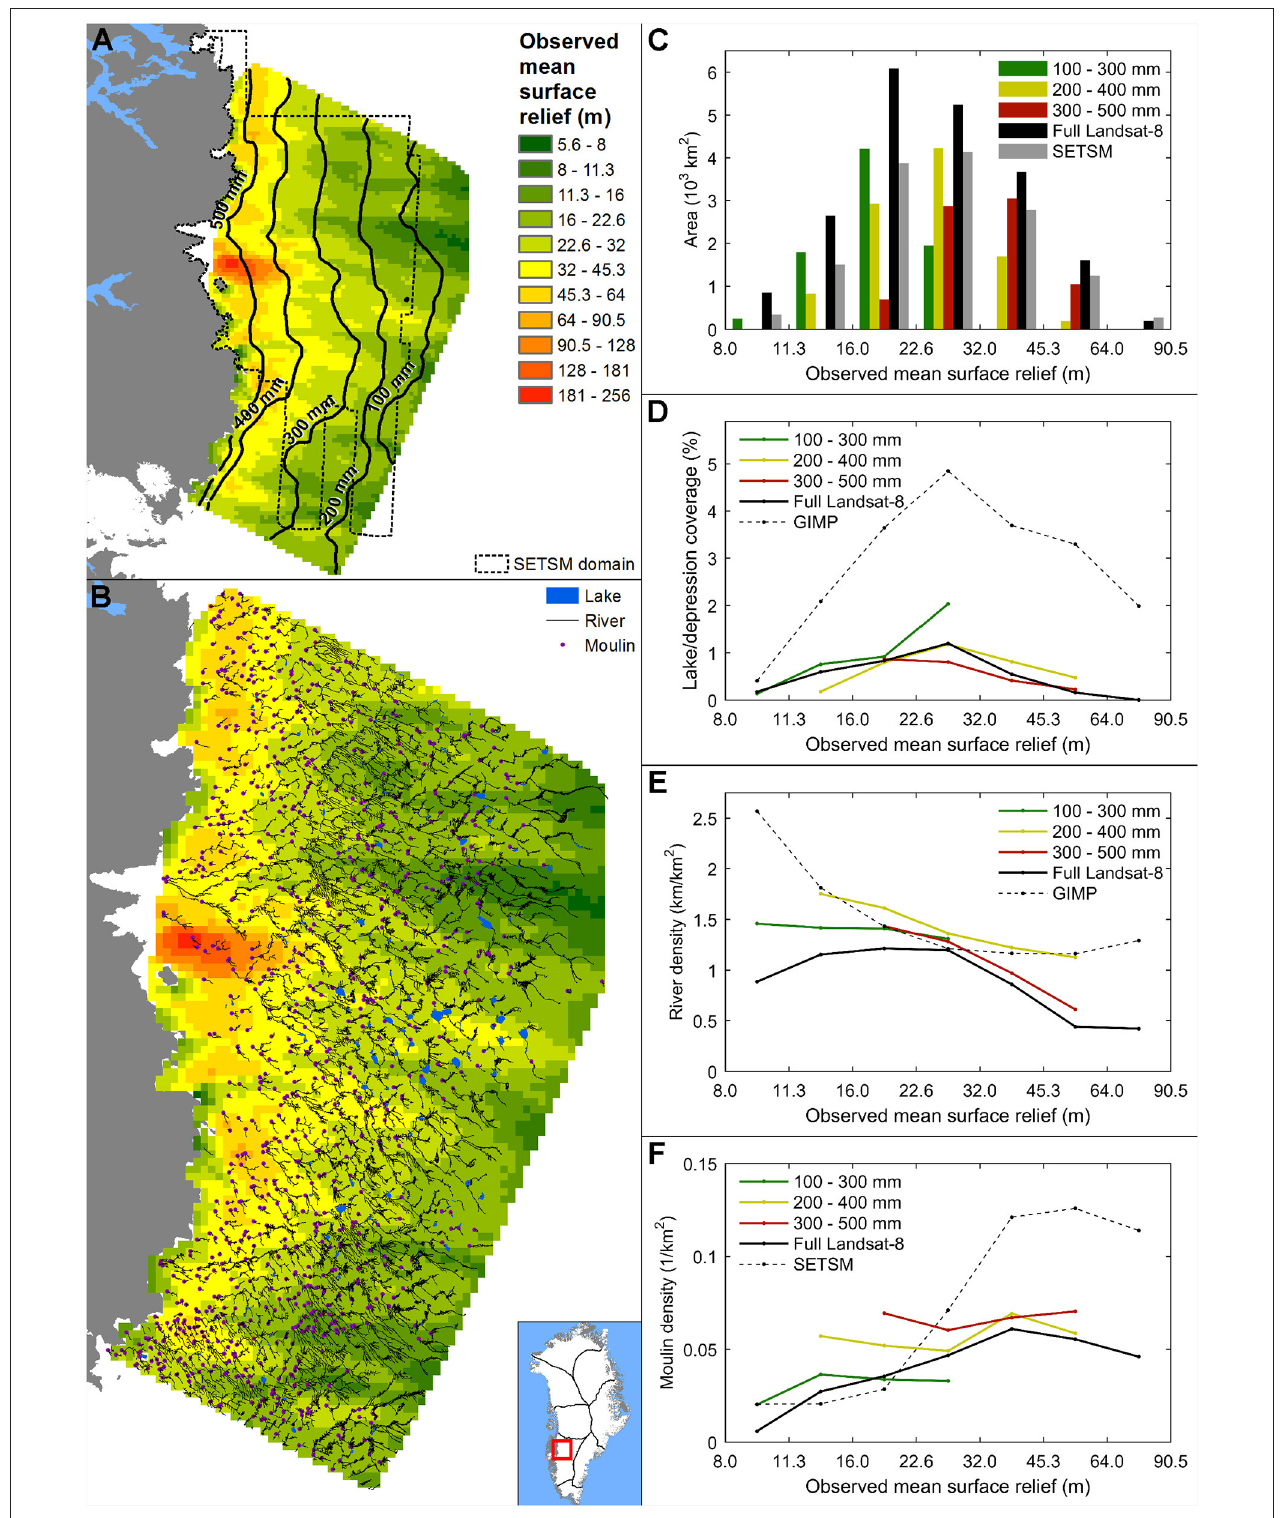
FIGURE 9 | (A) Observed mean surface relief map for the full Landsat-8 survey domain combined with the outlines of the SETSM domain (dashed boundary) and contours representing different levels of the modeled Aug, 2013 runoff. (B) Observed mean surface relief compared with the distribution of Landsat-8 derived surface lakes, rivers and moulins in SW Greenland. (C) Area histograms of the observed mean surface relief categories of the full Landsat-8 domain, SETSM domain, and